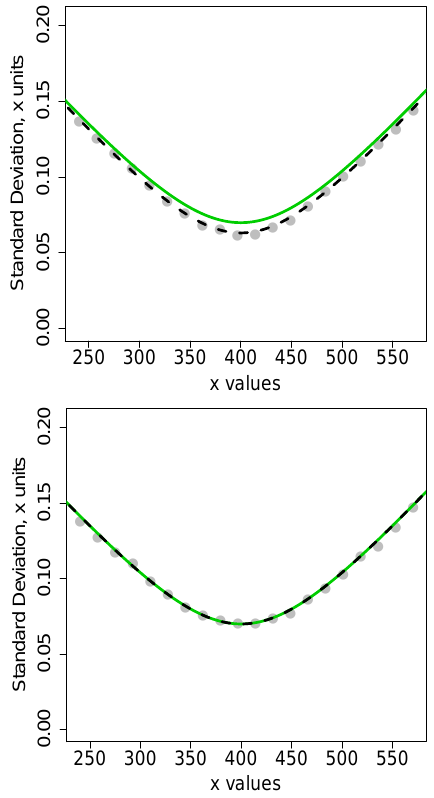
Fig. D1. Regression uncertainty for a typical CO 2 calibration. (a) Results for case A with σ y = 0.05, σ x = 0.03, and y = 0 . 8 x − 370. (b) Results for case B where σ x = 0. The green curves corre- spond to SD u described by Eqs. (D6) and (D7). The dashed curves correspond to SD 0 u where σ 0 y replaces σ y in Eq. (D7). The filled cir- cles represent the standard deviations across 2500 realizations for the simulated unknown samples from the Monte Carlo